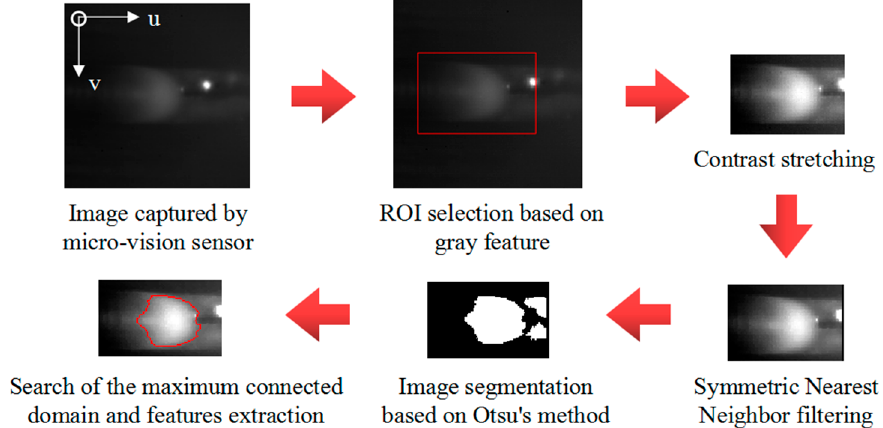
Figure 6. The processing result of each step of the proposed features extraction algorithm.